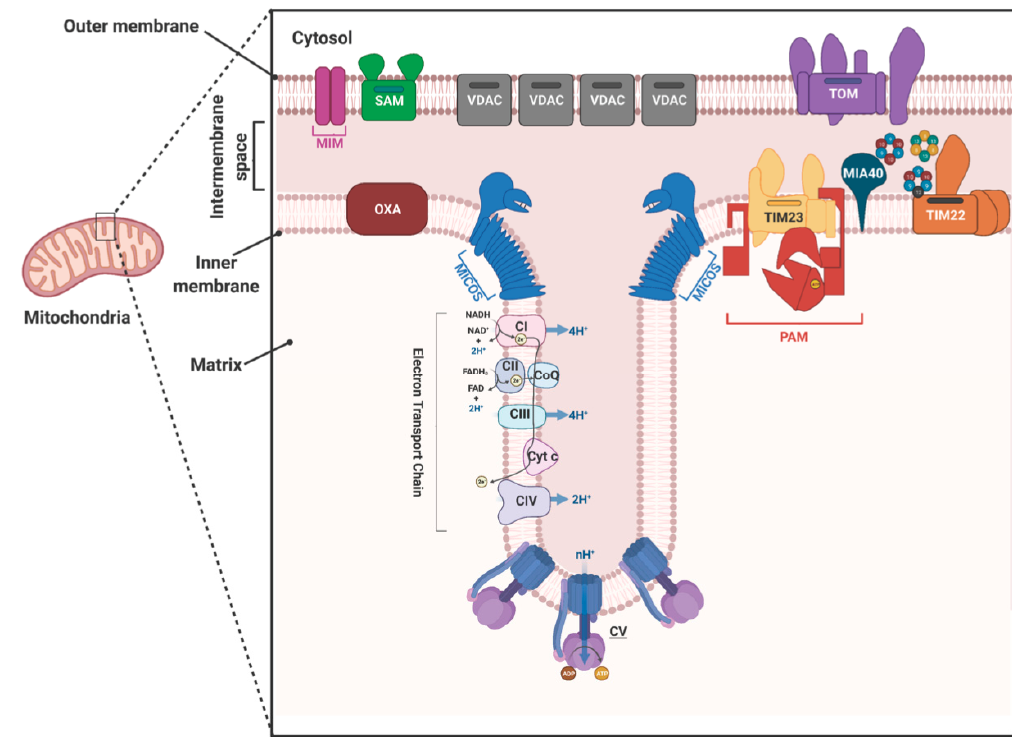
Figure 1. Schematics of protein complexes of the mitochondrial outer and inner membranes as identified in yeast. Mito- chondrial cristae junction and the contact site for the outer and inner membranes are enlarged. The Sorting and Assembly of the β -barrel proteins (SAM), MIM, and the translocase of the outer membrane (TOM), are involved in the import of β -barrel, α -helical, and all other nuclear-encoded mitochondrial proteins in and through the mitochondrial outer membrane, respectively. The voltage-dependent anion channel (VDAC) mediates small molecules and metabolite fluxes through the mitochondrial outer membrane. TIM23 and TIM22 are the major protein translocases of the mitochondrial inner mem- brane. Presequence translocase (TIM23)-associated motor complex (PAM) imports protein into the matrix. Small Tim com- plexes acts as chaperones for hydrophobic inner membrane proteins to cross the intermembrane space. MIA40 and OXA1 imports proteins to the intermembrane space and the inner membrane, respectively. Mitochondrial contact site and cristae organization system (MICOS) form the cristae junction. Respiratory complexes and ATP synthase (CI, CII, CIII, CIV, and CV) are localized in the cristae membrane. The picture was created with the BioRender.com.